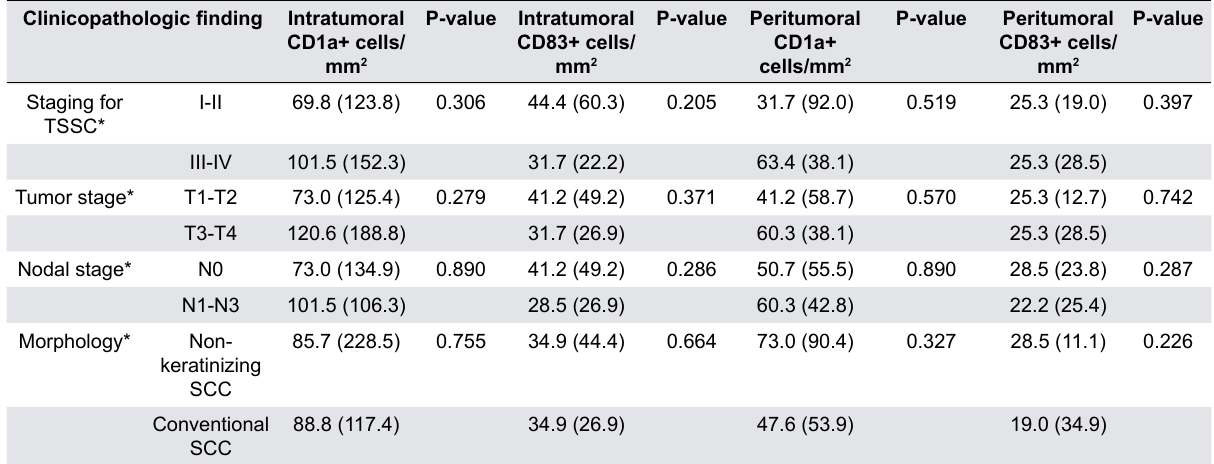
Figure 1- Immunohistochemical analysis of tonsillar squamous cell carcinoma (TSCC) and normal tonsil (NT). CD1a+ dendritic cells associated with HPV-positive TSCC (A) and HPV- negative TSCC (B) tumor cells. High expression of CD1a+ cells in NT sample (C). Decrease of CD83+ dendritic cells in HPV-positive TSCC (D) and HPV-negative TSSC (E) compared to NT sample (F). High magnification (x400) Table 2- Comparison between clinicopathologic findings and the number of intra and peritumoral dendritic cells in tonsillar squamous cell carcinoma patients (median and interquartile